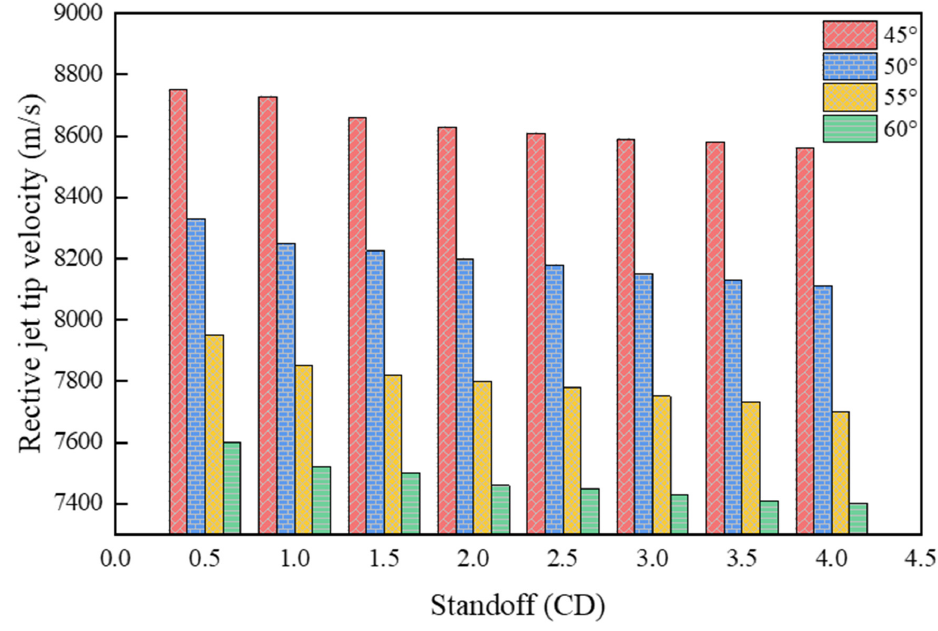
Figure 12. Reactive composite jet tip velocity influenced by the cone